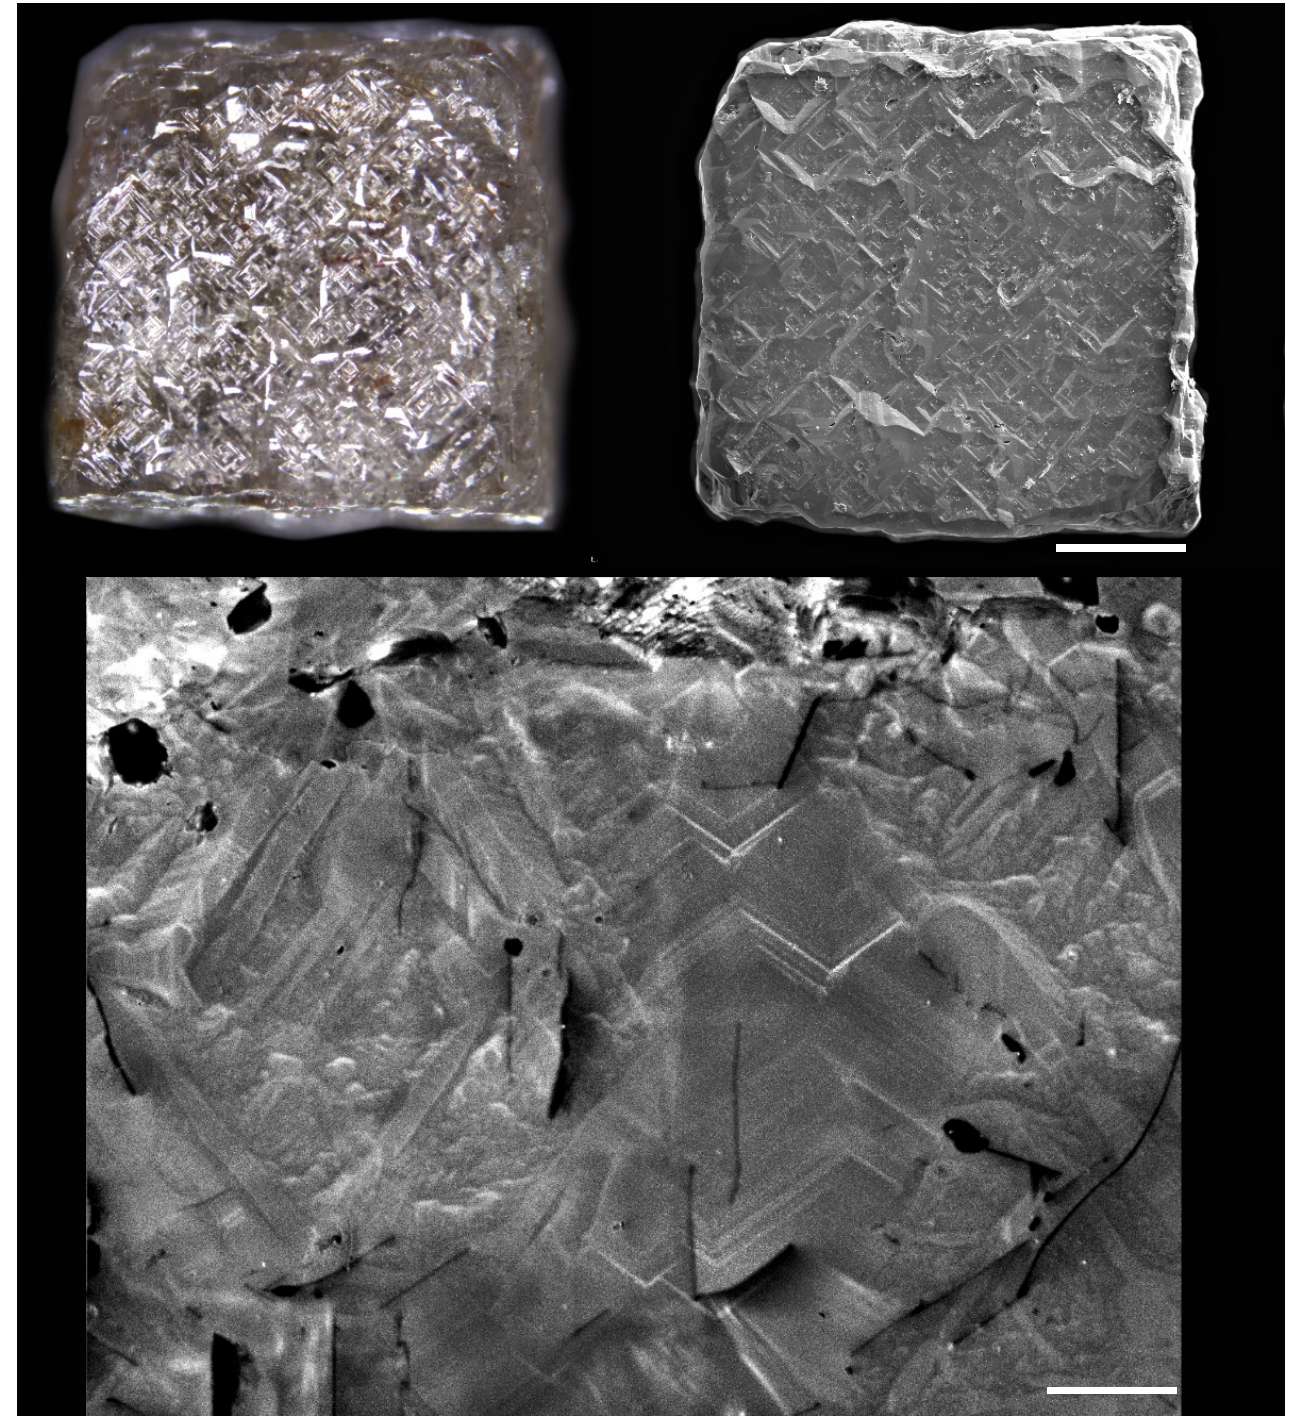
Figure 7. A cubic crystal with lamellae of tangential and normal growth in its internal structure. Top row: morphology of the crystal (OM image and SEI, the scale bar is 1 mm); bottom row: CL image of a (110) plate (the scale bar is 50 μ m).